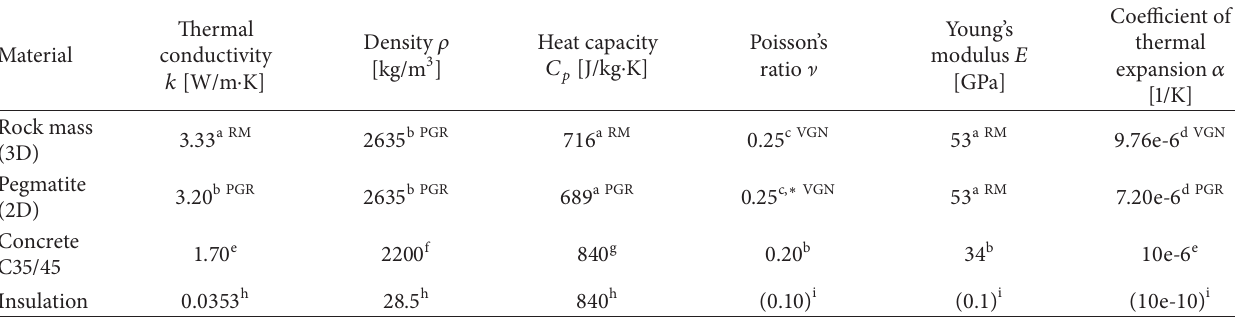
Table 3: Material properties used in simulations.